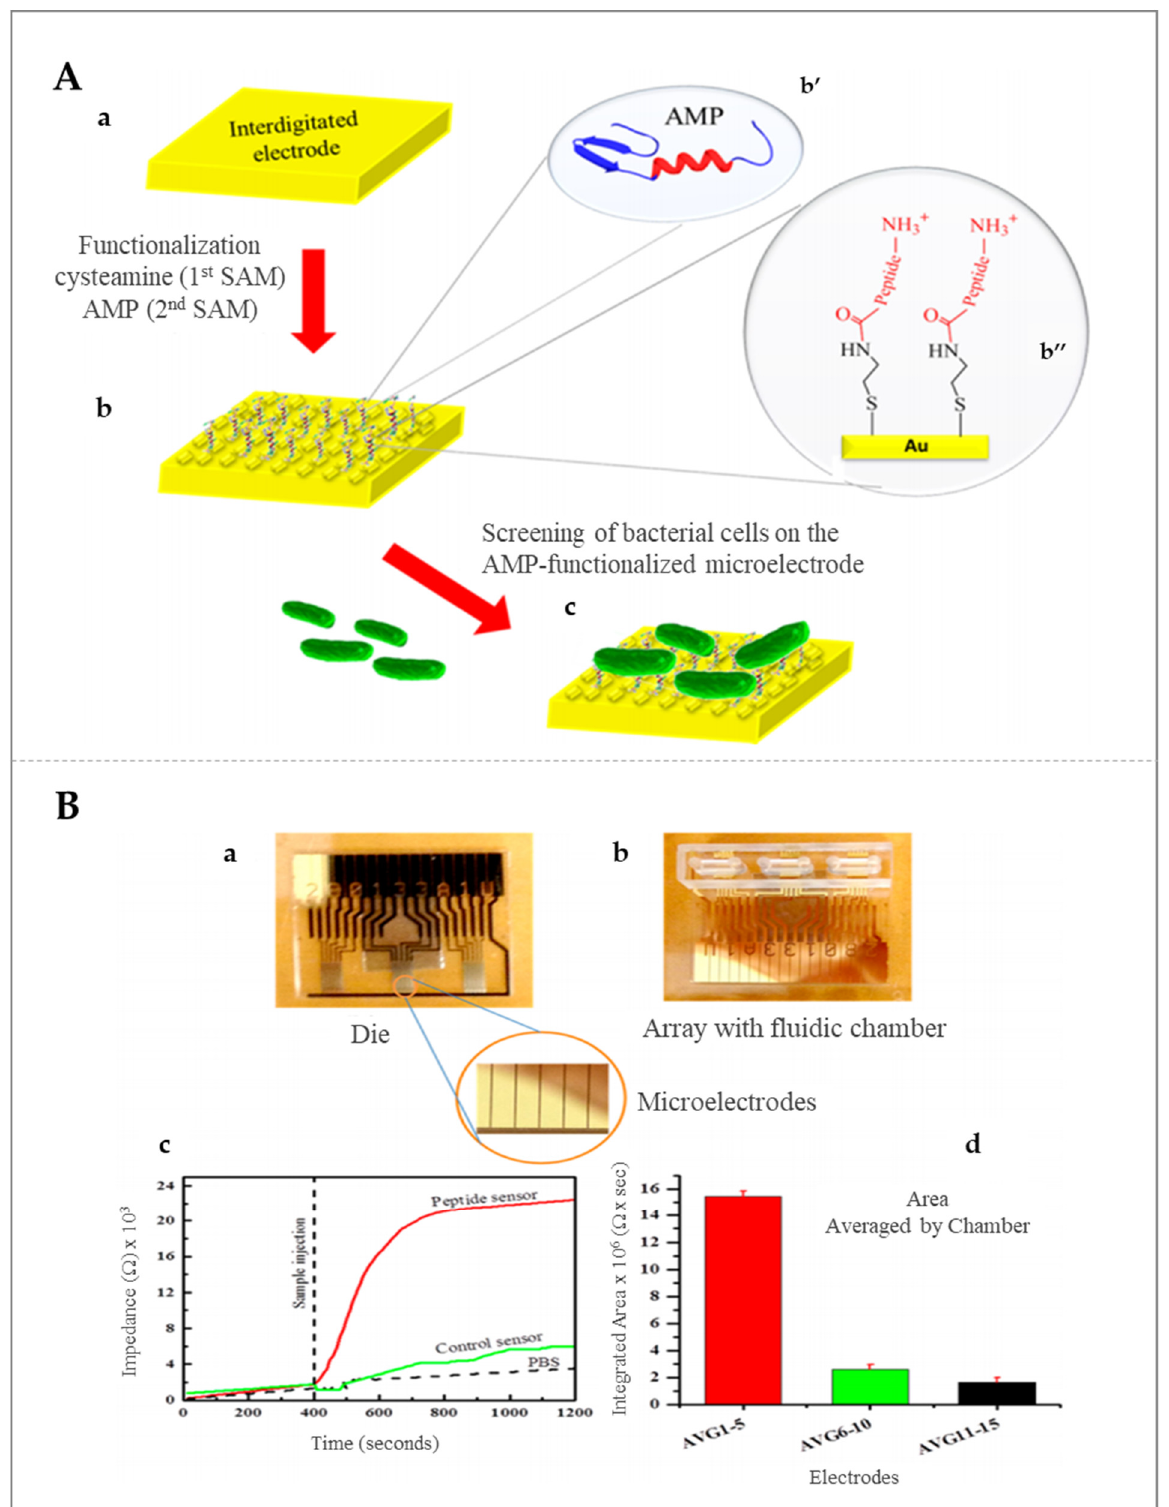
Figure 5. ( A ) Schematic representation of the AMP-based biosensor for L. monocytogenes detection at interdigitated microelec- trode modified with antimicrobial peptides (AMP); (a) representation of the interdigitated electrode; (b) functionalization of the electrode with cysteamine AMP; (c) screening of bacterial cells. ( B ) Real-time measurements of binding of bacteria to the peptide sensor; (a) representation of the experimental assembly with the highlighting of the microelectrodes; (b) rep- resentation of array with fluidic chamber; (c,d) testing the peptide-based sensor. Copyright (2021) American Chemical Society